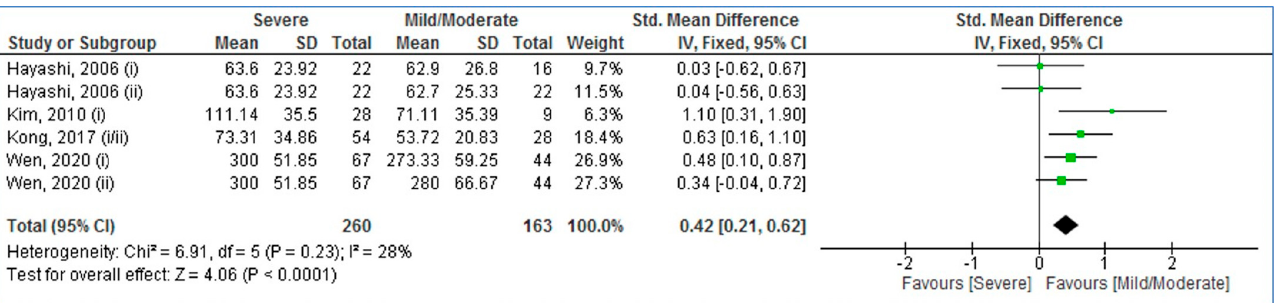
Figure 3. Forest plot analysis comparing blood levels of monocyte chemotactic protein-1 in mild/moderate compared to adults with severe obstructive sleep apnea. SD: Standard deviation. CI: Confidence interval [22,23,36,37].